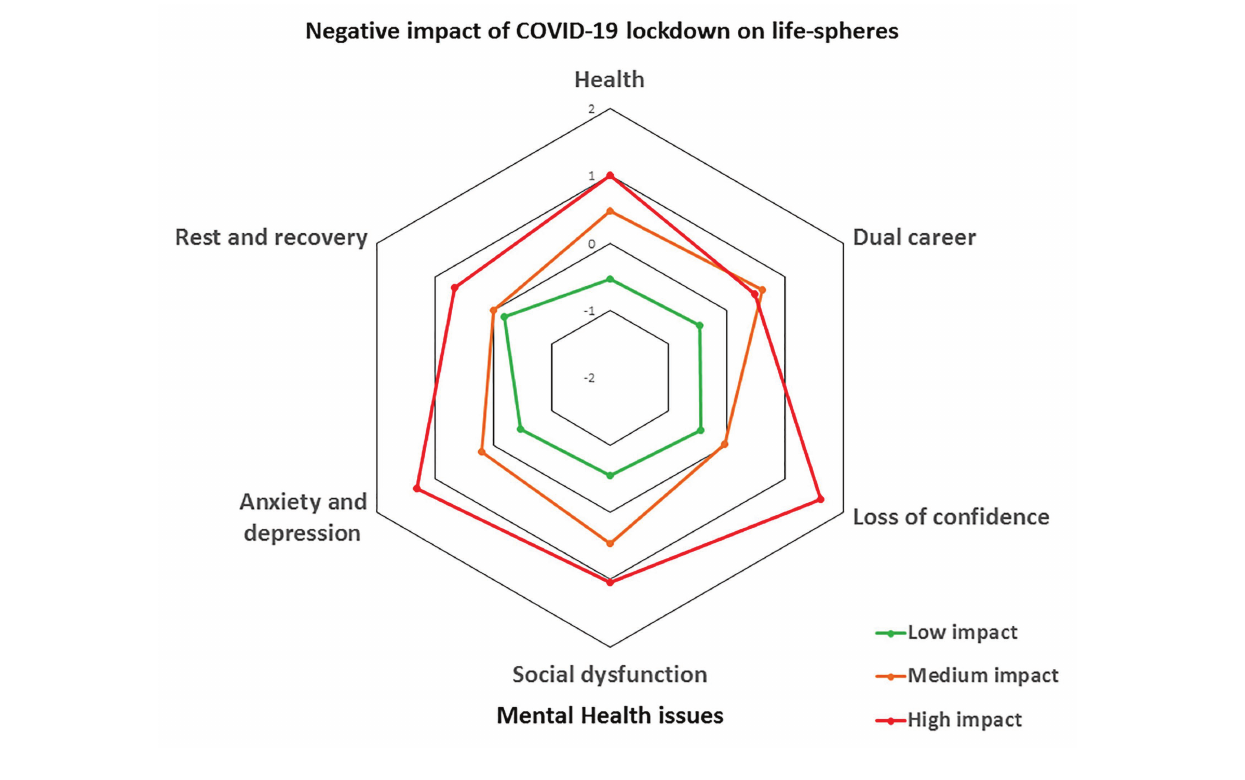
FIGURE 1 | Accepted cluster solution (standardized scores).